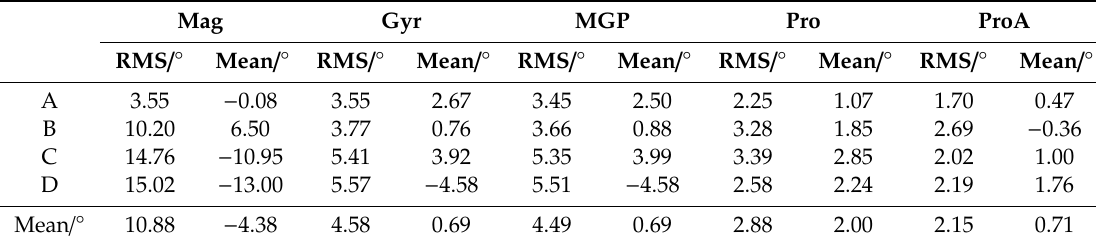
Table 2. The statistic of heading errors for